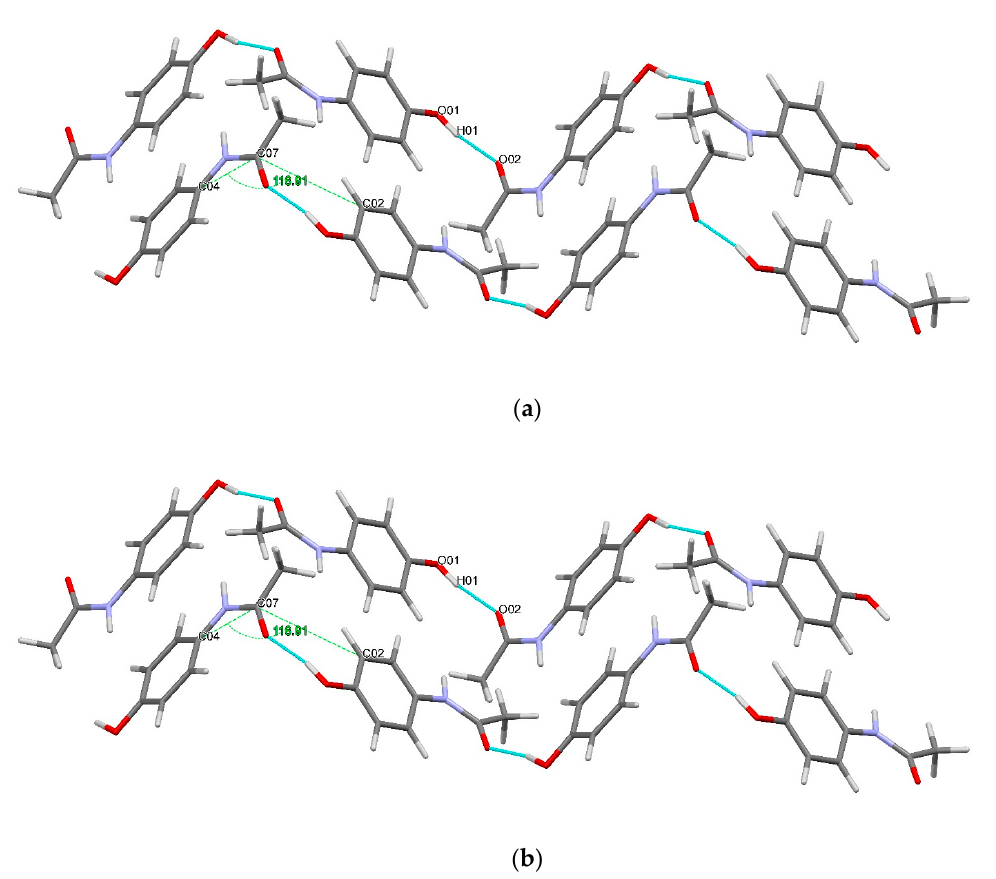
Figure 5. Diagram showing the packing motif of the PCM molecule in ( a ) ( 1 ) and ( b ) ( 3 ) [28].